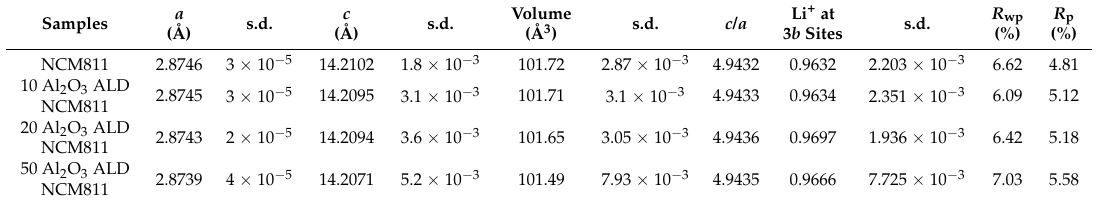
Table 1. Crystal parameters of different Al 2 O 3 -coated NCM811 materials in comparison to bare NCM811, according to XRD patterns and refinement results as shown in Figure 2.